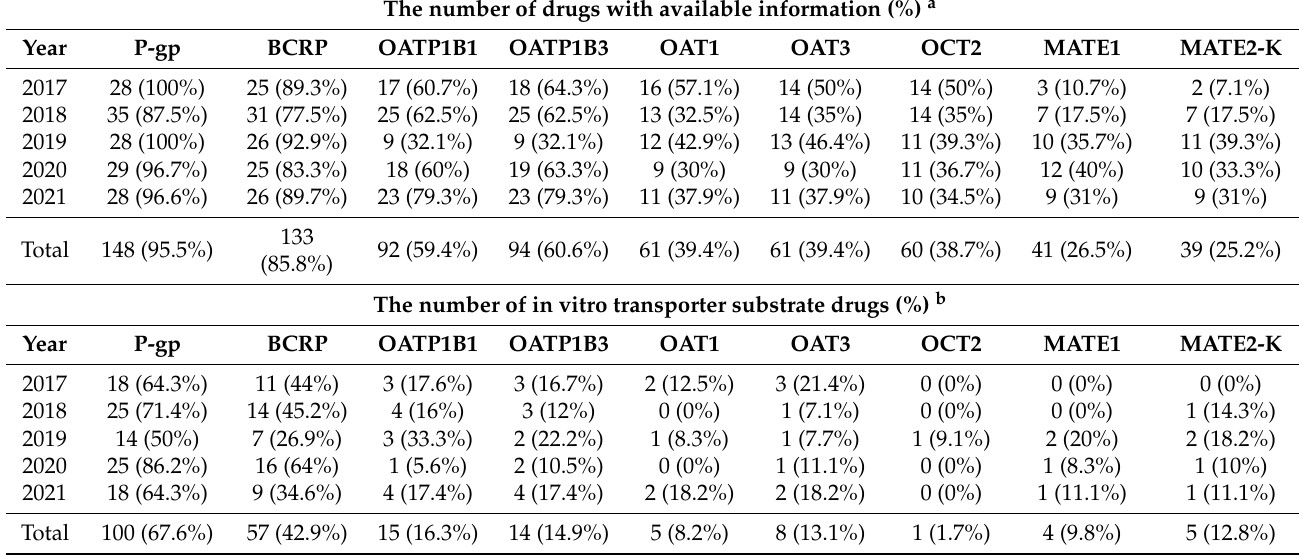
Table 4. Drugs with available information on transporter substrates and in vitro transporter substrate